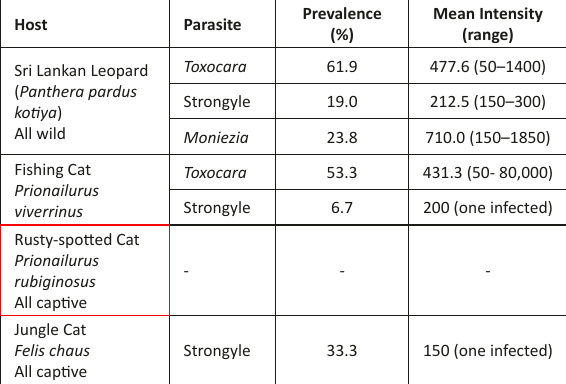
Table 4. Types of parasites, their prevalence and intensity in the four cat